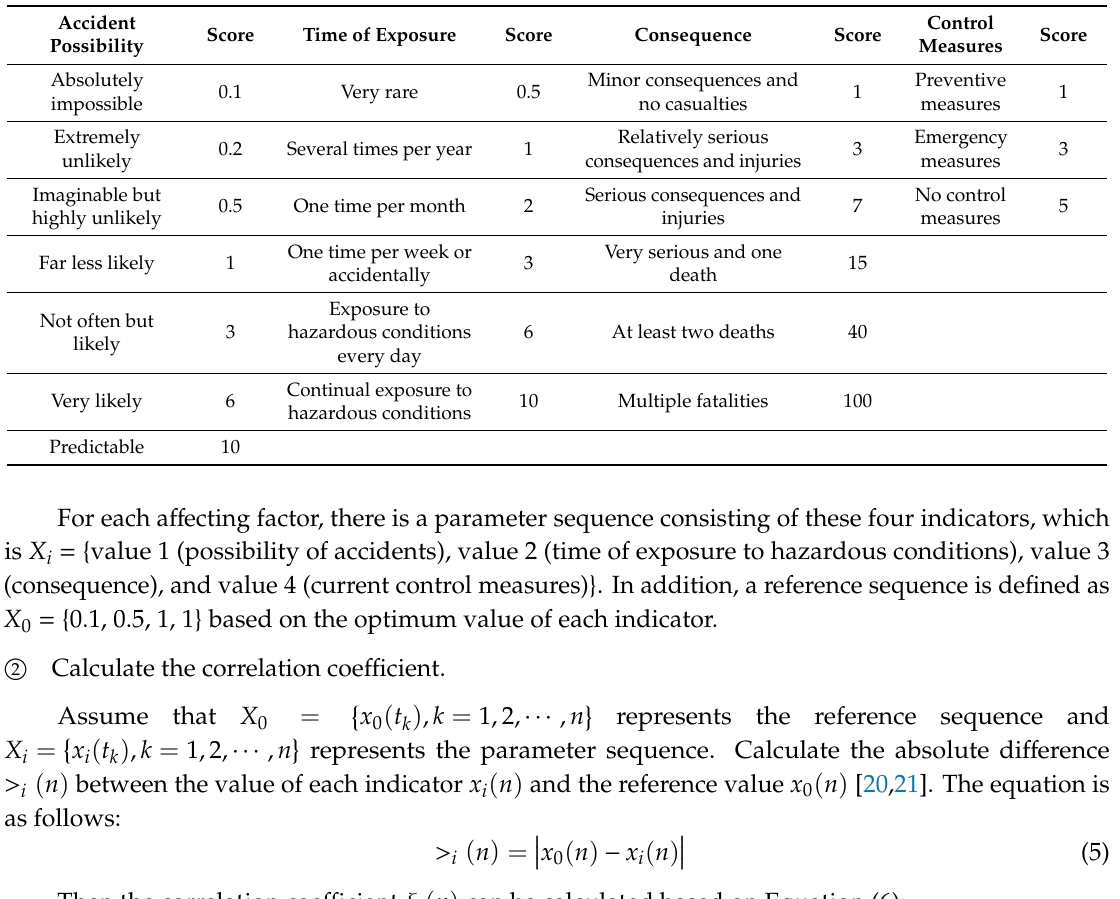
Table 1. The grading standards of correlation